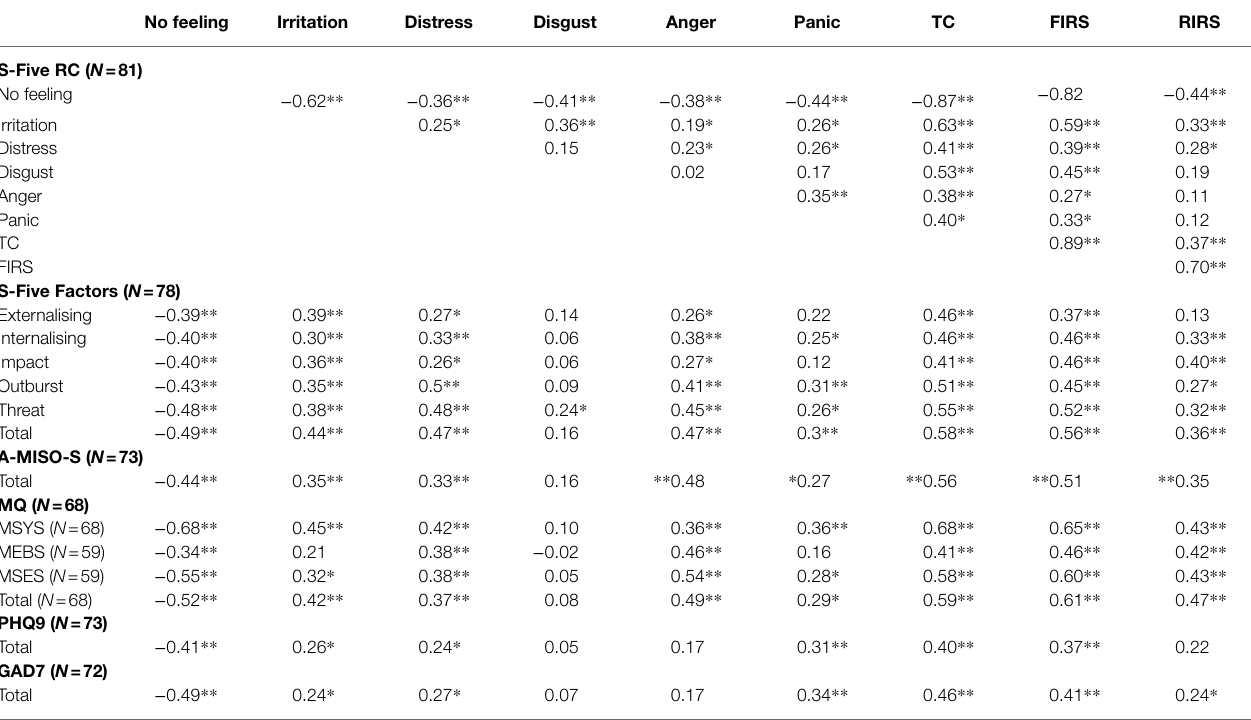
TABLE 5 | Intercorrelations of the S-Five, S-Five-T scores, and correlations with other measures (Spearman’s rho). No feeling Irritation Distress Disgust Anger Panic TC FIRS RIRS S-Five RC ( N = 81) No